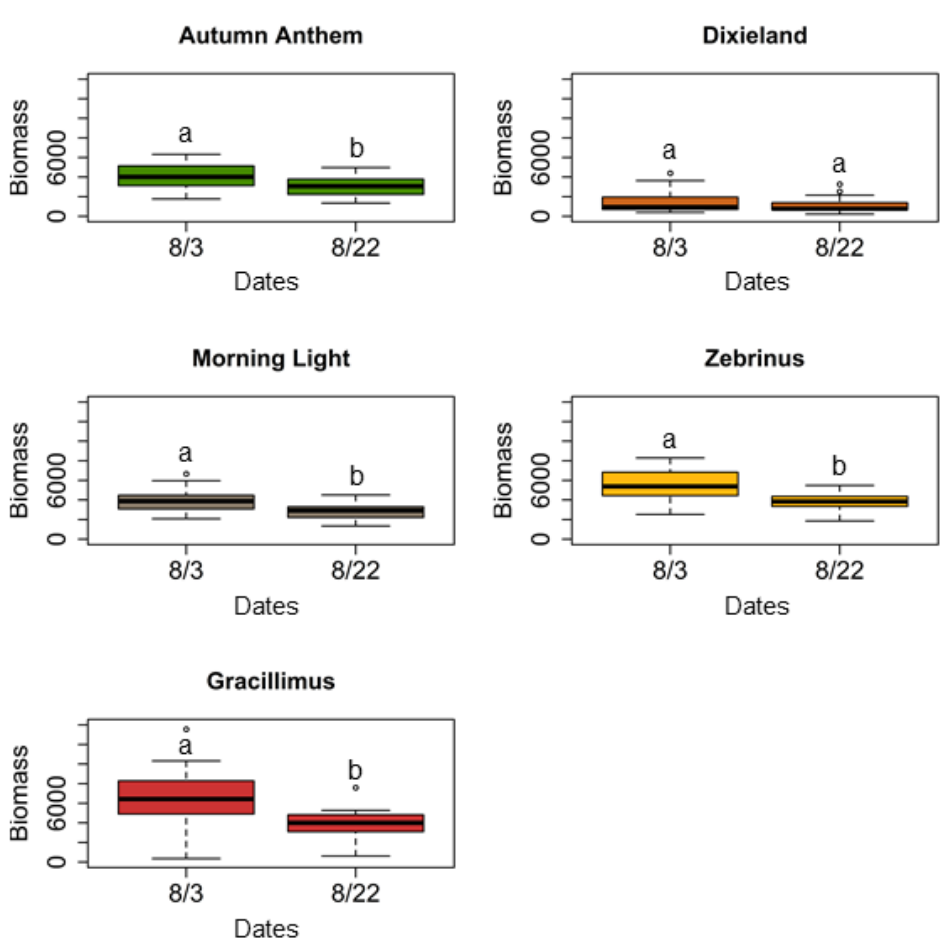
Figure 3. Comparisons of plant biomass changes of M. sinensis cultivars during the cage experiment at the Research Plant Growth Facility of the University of Maryland (College Park, MD, USA) in 2018. Box plots represent measurements of the product [height × number of leaves], as a proxy for plant biomass, which was used for comparisons. Data comparisons were conducted using one-way repeated measures ANOVA; plant biomass changes that do not share a letter is significantly different based on post hoc Tukey HSD test (Tukey HSD: p < 0.05).